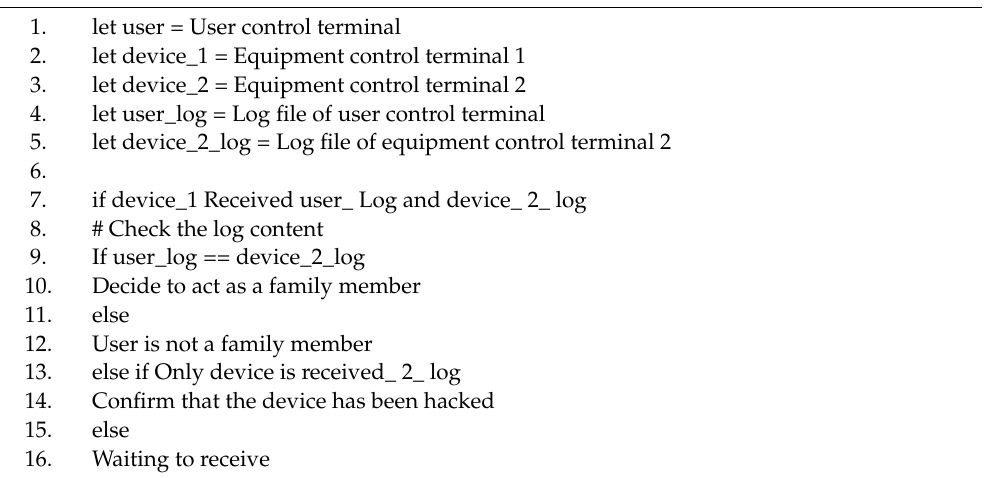
Algorithm 2 Virtual code for judging operation result at equipment control